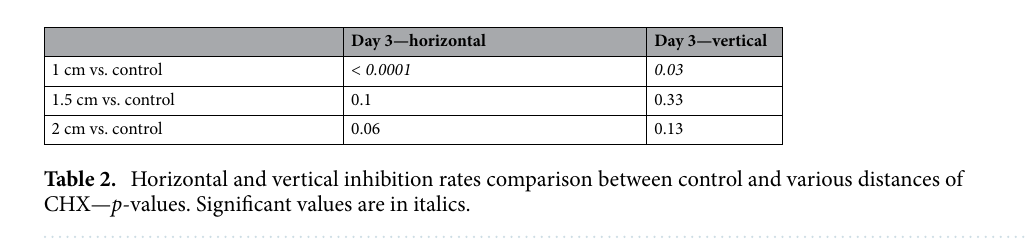
are shown in bright red. ( b ) Colony periphery deformation analysis. At each distance from CHX source (control and 1/1.5/2 cm) the ratio between horizontal (left) and vertical (right) radii between the unexposed and exposed halves is shown.